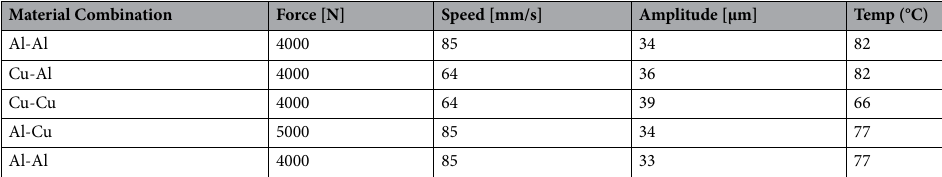
Table 1. Ultrasonic additive manufacturing (UAM) processing parameters used for bonding the various Al and Cu material combinations. (Due to the UAM process dynamics, parameters must be adjusted as the height of the part increases to account for an increased height to width ratio 40,43